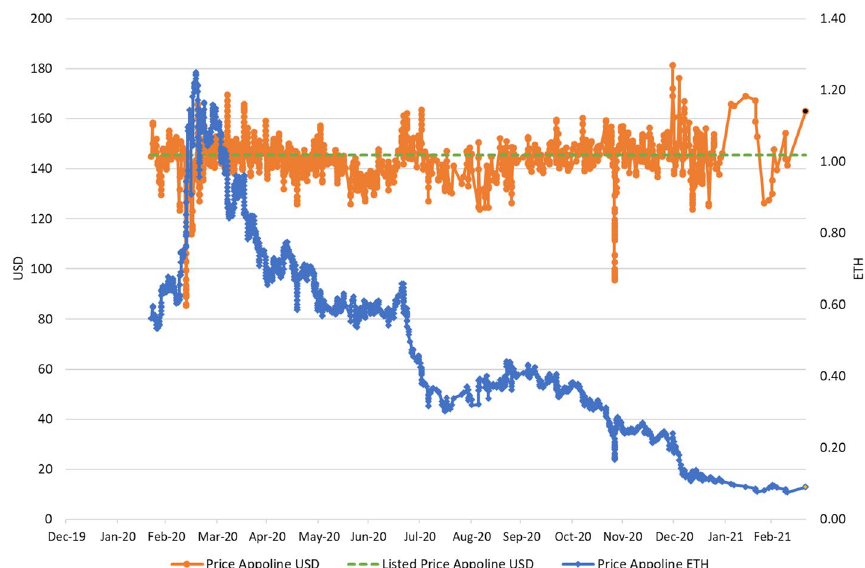
Fig. 14 Price (in USD and ETH) of 10,024 Appoline Street Detroit MI. Each dot represents one transaction. Last colored dot is ask price on Uniswap